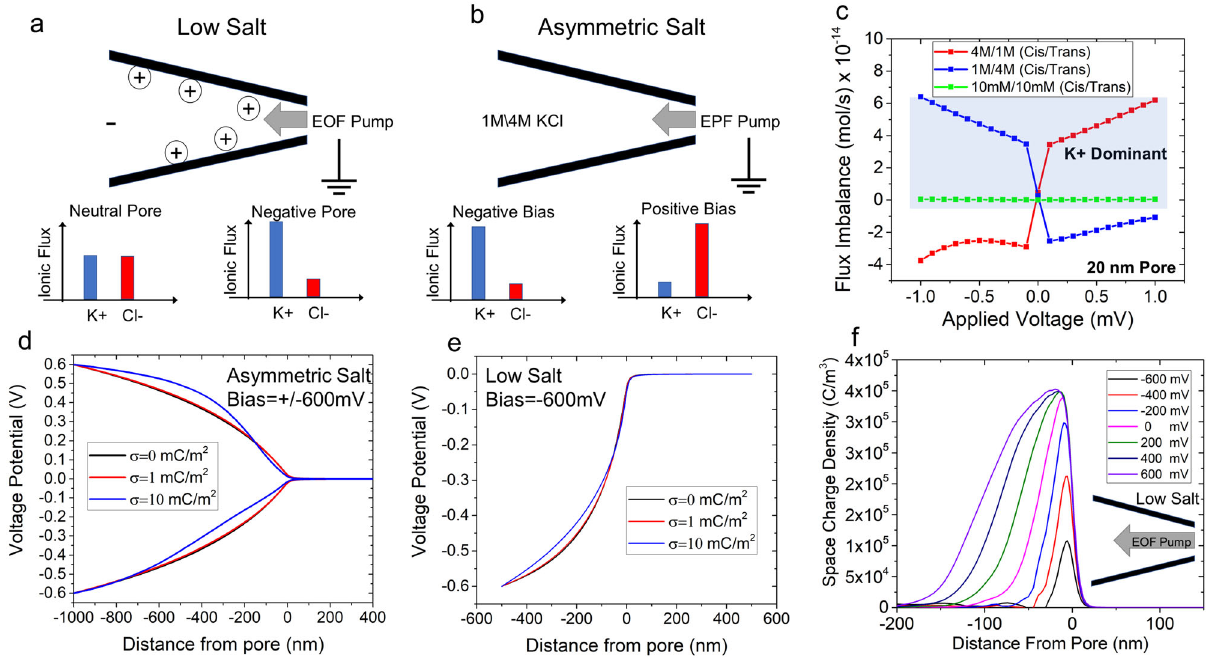
Fig. 3 Conceptual and computational model of symmetric low-salt conditions and asymmetric salt conditions. a A graphical representation of a negatively charged glass nanopipette under low-salt conditions. When a negative voltage is applied, EOF is directed into the pore The fl ux imbalances for a neutral pore and a negatively charged pore (our experiments) can be found at the bottom. Negatively charged pores enable a fl ux imbalance in favor of cations to occur when the pore has a negative potential. b An illustrative fi gure displaying EPF ion pumping for asymmetric salt conditions with 1 M KCl inside the pore and 4 M KCl outside. The graphs at the bottom represent a negative and positive voltage bias with the resulting fl ux imbalance. c Flux imbalance calculations for symmetric and asymmetric salt conditions (both conditions where 1 M (cis)/4 M (trans) and 4 M (cis)/1 M (trans) are shown). Asymmetric salt permits the toggling of the fl ux imbalance with either a change in voltage or concentration gradient formation. A blue shaded region is overlaid upon the region that is K + dominant. The symmetric low salt (10 mM/10 mM) curve is also provided in the Supplementary Information and shows that the pore is always cationic-selective. The potential distribution under d asymmetric salt conditions and e low-salt conditions for three surface charge densities (electric potential is plotted along the axis of symmetry). f Space charge density (C/m 3 ) for the voltage range of − 600 mV to + 600 mV (axial distance of zero corresponds to the tip of the nanopipette). The pore diameter for this simulation was 20 nm under low-salt conditions (10 mM KCl) and the schematic illustrates EOF pump directed towards the